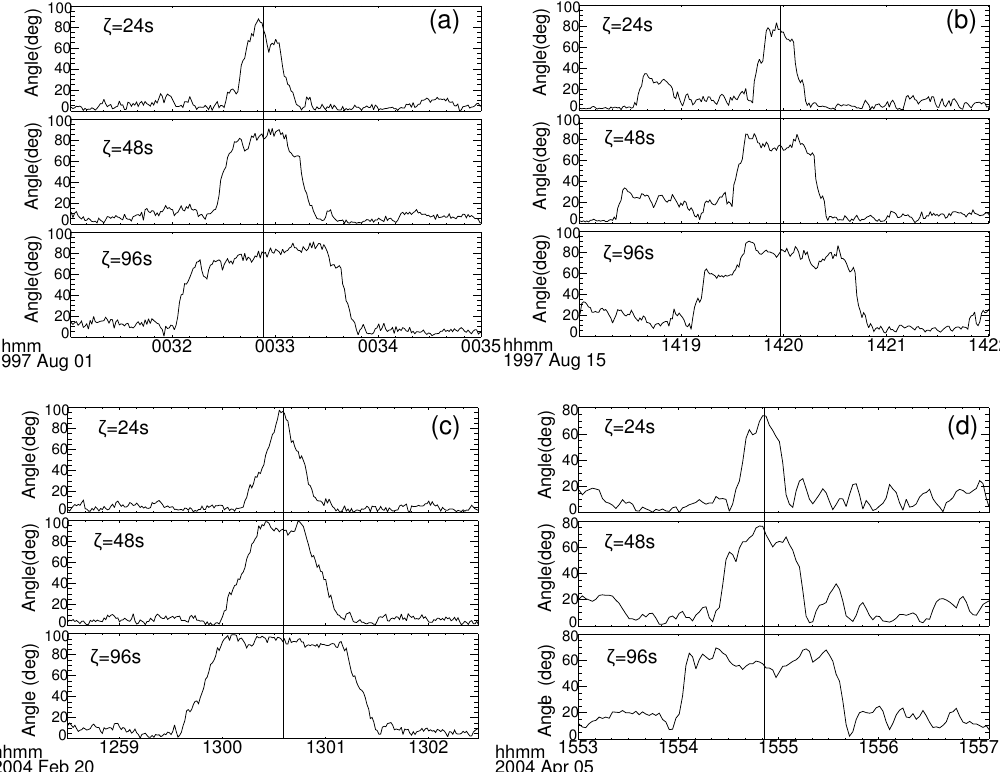
Fig. 2. Four cases to show the current sheet searching procedure. In each case, 1θ as a function of ζ and t are shown for three different ζ ’s: ζ = 24, 48 and 96s. The x-axis is the UT time and the y -axis is the deflection angle 1θ . The vertical lines in (a) , (b) , (c) , and (d) are the centers of the corresponding current